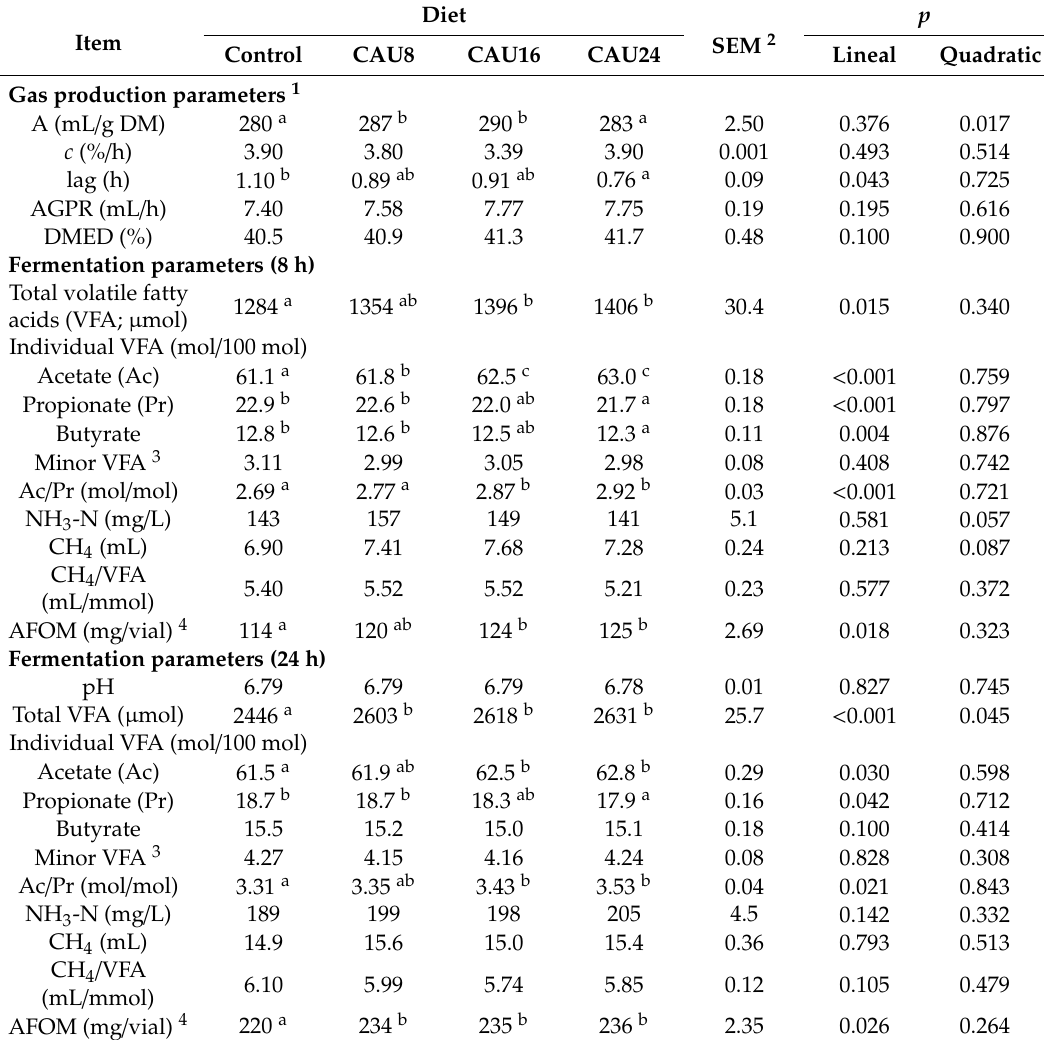
Table 6. Gas production and fermentation parameters of experimental diets containing 40% alfalafa hay and 60% concentrate with increased amounts of Brussels sprouts (BS; 8, 16 and 24% of concentrate fresh